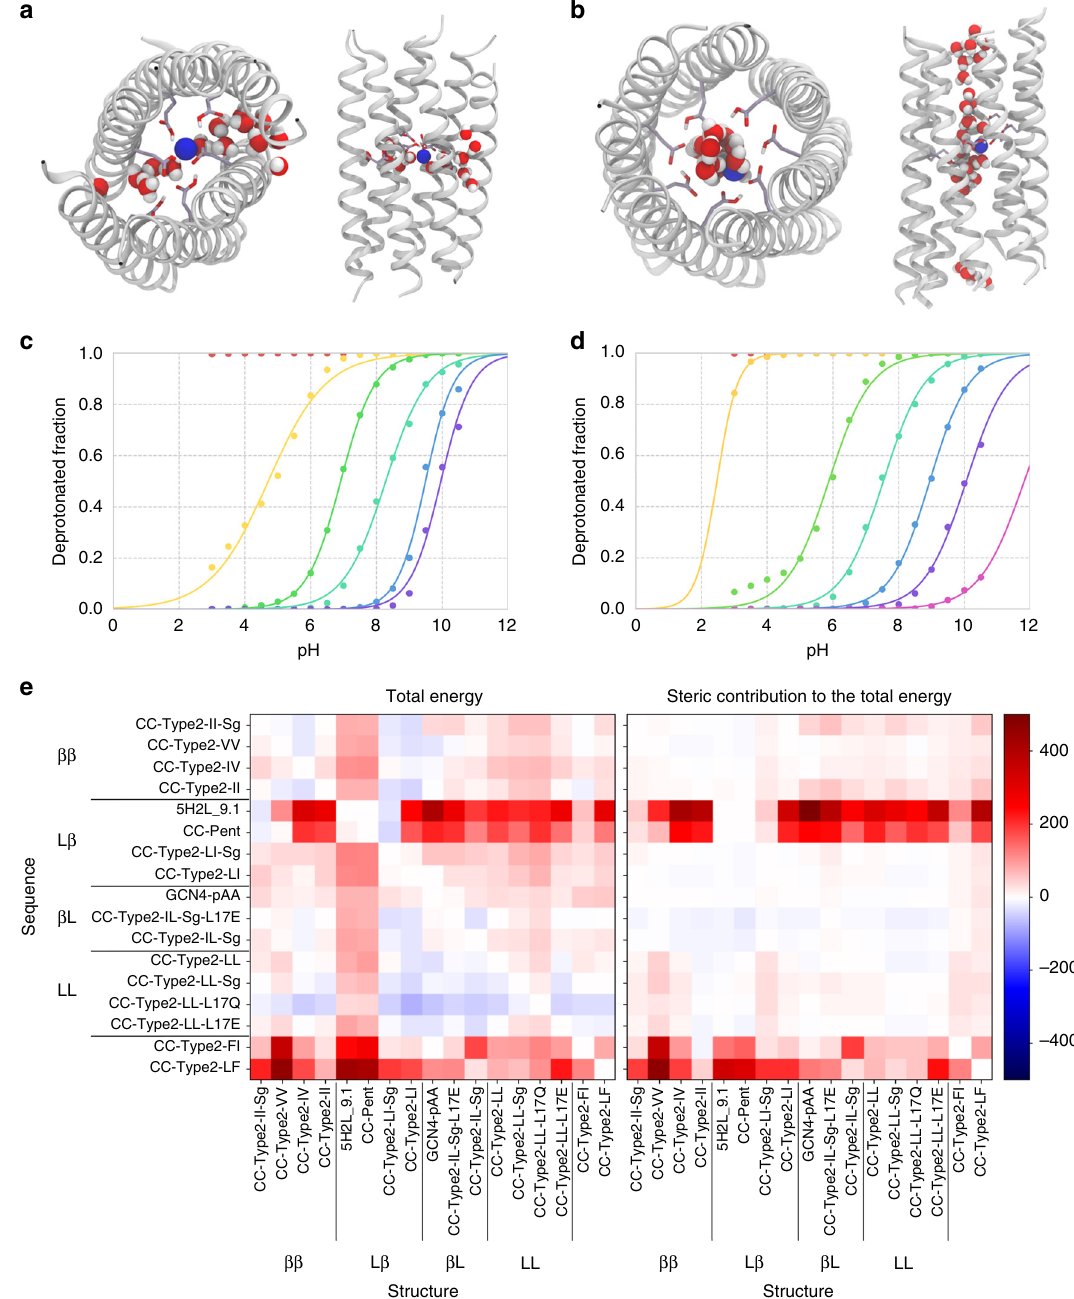
Fig. 7 Computational analysis of the CC structures. a , b Orthogonal views of snapshots from the CpHMD simulations of CC-Type2-LL-L17E ( a ) and CC-Type2-IL-Sg-L17E ( b ) at pH 4. The backbone structures are represented by ribbons, Glu-17 with purple sticks, and water molecules and sodium ions (blue) as van der Waals ’ spheres. c , d Stepwise pH titration of the Glu-17 cluster in CC-Type2-LL-L17E ( c ) and CC-Type2-IL-Sg-L17E ( d ) obtained through CpHMD. From left to right, titration events are ð G lu 17 Þ 1 (cid:2) x to ð G lu 17 Þ 2 (cid:2) x (yellow), ð G lu 17 Þ 2 (cid:2) x to ð G lu 17 Þ 3 (cid:2) x (green), ð G lu 17 Þ 3 (cid:2) x to ð G lu 17 Þ 4 (cid:2) x (turquoise), ð G lu 17 Þ 4 (cid:2) ð G lu 17 Þ 5 (cid:2) ð G lu 17 Þ 5 (cid:2) ð G lu 17 Þ 6 (cid:2) ð G lu 17 Þ 6 (cid:2) ð G lu 17 Þ 7 (cid:2) ð G lu 17 Þ 0 ð G lu 17 Þ 1 (cid:2) x to x (blue), x to x (purple) and x to x (pink). Note that the x to x (red) transitions are not observed in the pH range modelled. Calculated p K a s are tabulated in Supplementary Tables 8 and 9. e Normalised per-chain BUDE scores from modelling all sequences (rows) onto all structures (columns) in ISAMBARD, with total energy in BUDE points (left) and the extracted steric component (right). For each row, raw scores were normalised relative to the score for the named sequence modelled onto its cognate backbone structure (i.e., the top-left-to-bottom-right diagonal), which is assigned zero and represented by white boxes. In this scheme, red boxes correspond to worse scores and less-favourable pairings of that sequence with the different structures modelled through the row, i.e., if atom – atom clashes appear in the model; and blue boxes represent better scores indicating that the sequence is accommodated better into the alternate